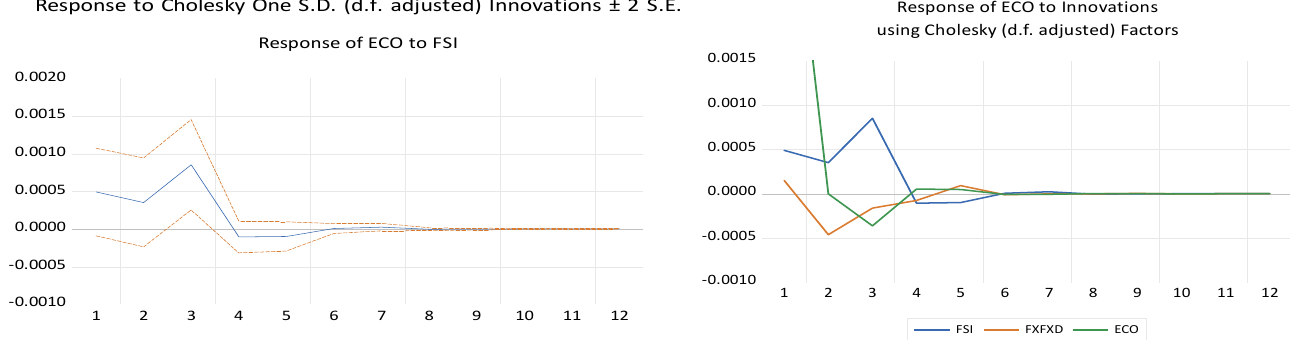
Figure 3. Response of output to FSI and FXFXD